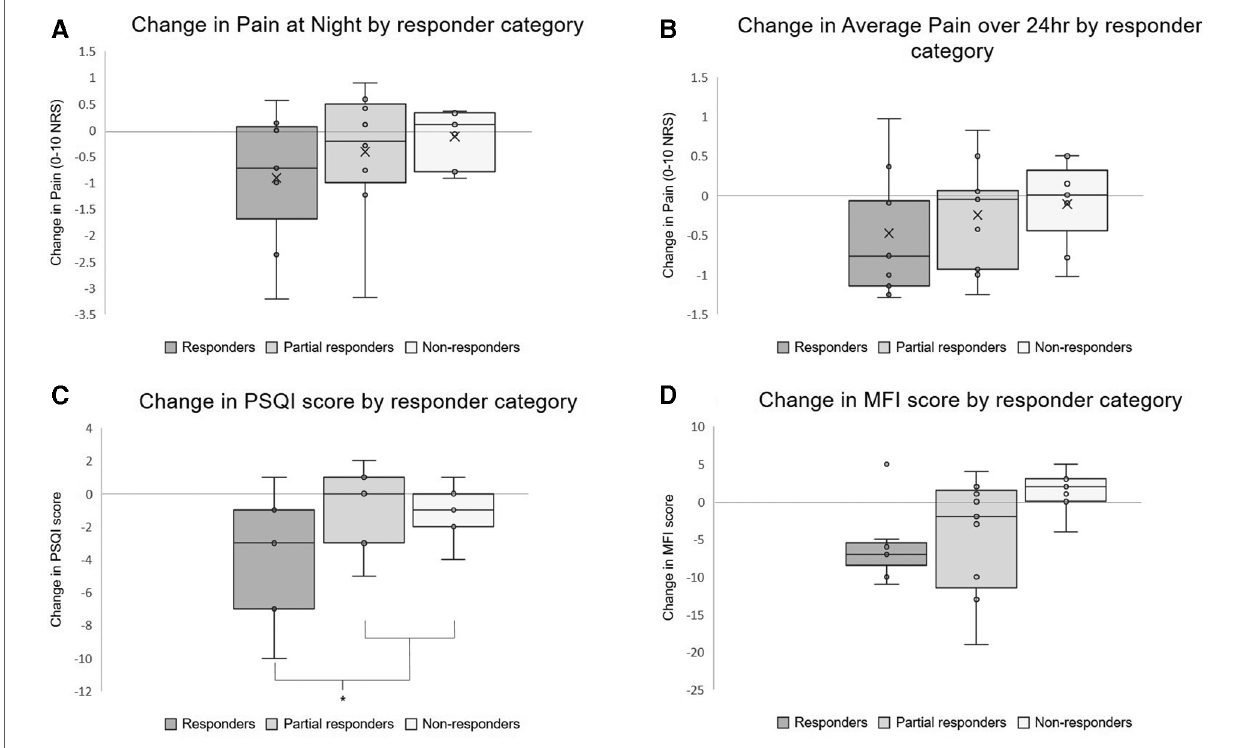
FIGURE 4 Boxplots showing selected outcomes by responder category. Responders are participants who reported an improvement in the brief pain inventory pain interference score by at least 1 point, partial responders by less than 1 point, non-responders showed no change or worsening. Arithmetic means represented by “ X ” in panels A and B, not included in the non-continuous variables. *Statistically signi fi cant difference between responders and other categories in PSQI change ( p